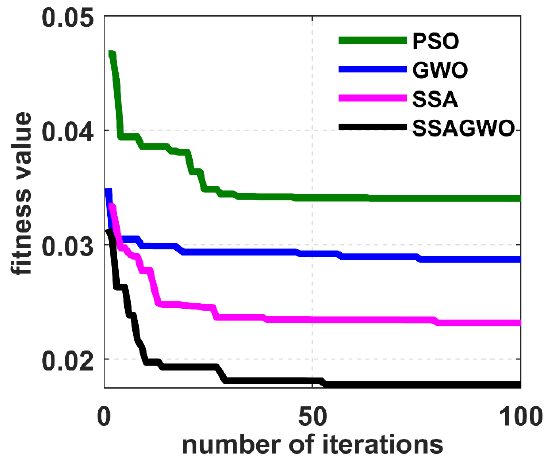
Figure 18. Convergence curve of the algorithms.